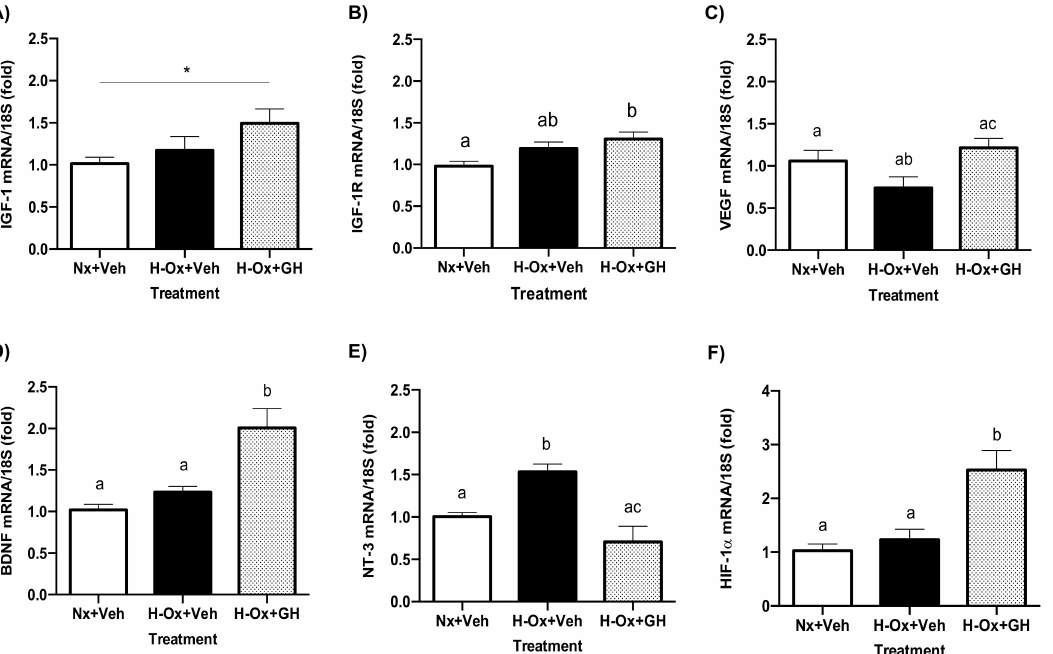
Figure 8. Effects of hypoxia and GH treatment upon the expression of mRNAs encoding for the neurotrophins IGF-1, VEGF, BDNF, NT-3, as well as IGF1-R and HIF-a in the embryonic chicken cerebellum. The relative expression of ( A ) IGF-1, ( B ) IGF1-R, ( C ) VEGF, ( D ) BDNF, ( E ) NT-3, and ( F ) HIF-1 a mRNAs were determined by qPCR. Ribosomal 18S RNA was used as housekeeping gene control. Bars represent the mean ± SEM, n = 5 independent experiments by duplicate. Groups with different letters are significantly different by one-way ANOVA and Tukey’s post hoc test. Asterisk (*) represents differences by Student’s t test ( p <